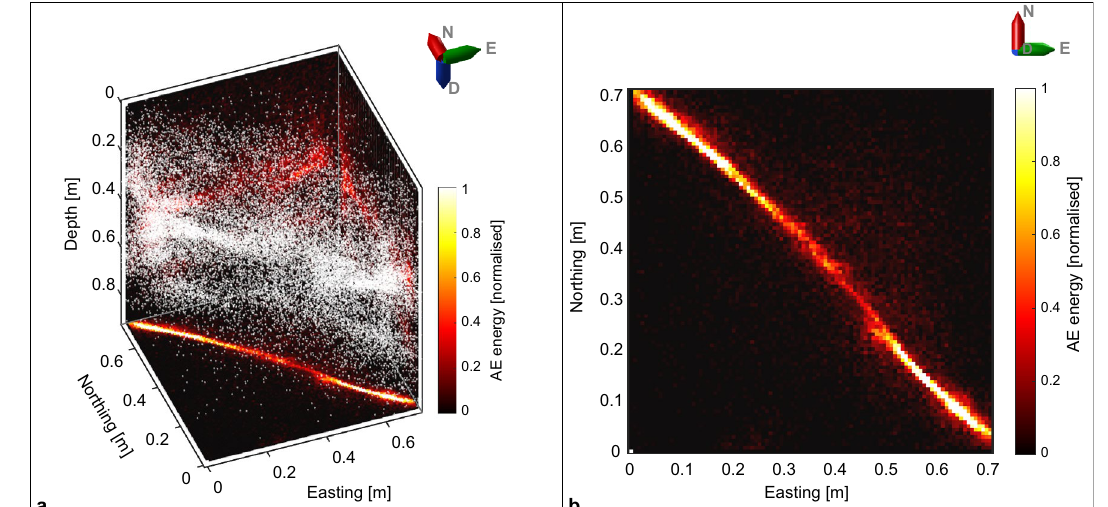
Figure 3. AE events of the first 20 stages of the experiment preceding the high-pressure injection. ( a ) 3D-view of the block with individual event locations (white dots) and color-coded cumulative AE energy of all located events. ( b ) Plan-view of the cumulative AE energy. Most of the events are located right at the interface, with slightly less energy originating from the central part of the interface.